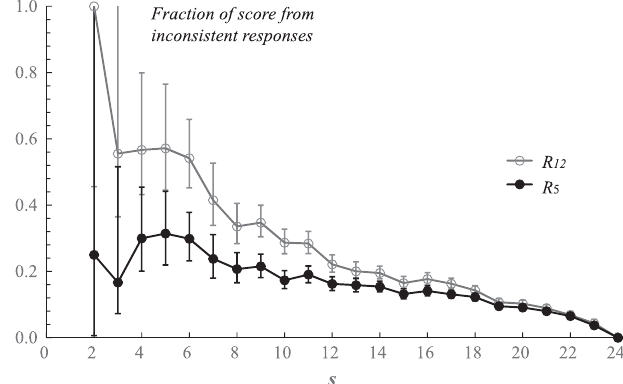
FIG. 4. The fractions of score contributions from all 12 question pairs ( R 12 ) and from the 5 inconsistent pairs ( R 5 ) plotted as functions of